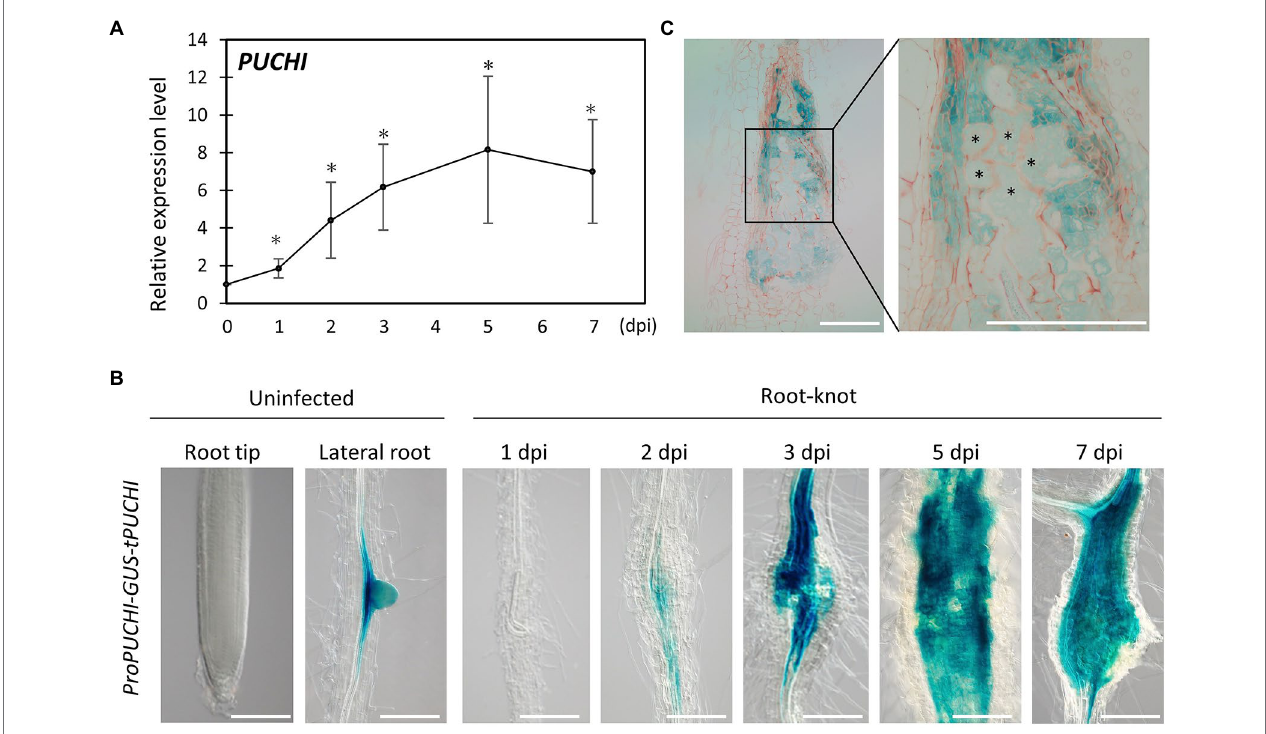
FIGURE 1 | PUCHI expression analysis. (A) Quantitative RT-PCR results of PUCHI transcript levels in 1–7 dpi galls and uninfected roots. Means ± standard error is shown. * p < 0.05 using Steel’s multiple comparison test. (B) GUS-stained ProPUCHI-GUS-tPUCHI 1–7 dpi galls and uninfected roots to denote the spatial expression patterns of PUCHI. (C) GUS-stained cross-sections of 7 dpi ProPUCHI-GUS-tPUCHI galls. * denotes GCs. Scale bars: 100 μ